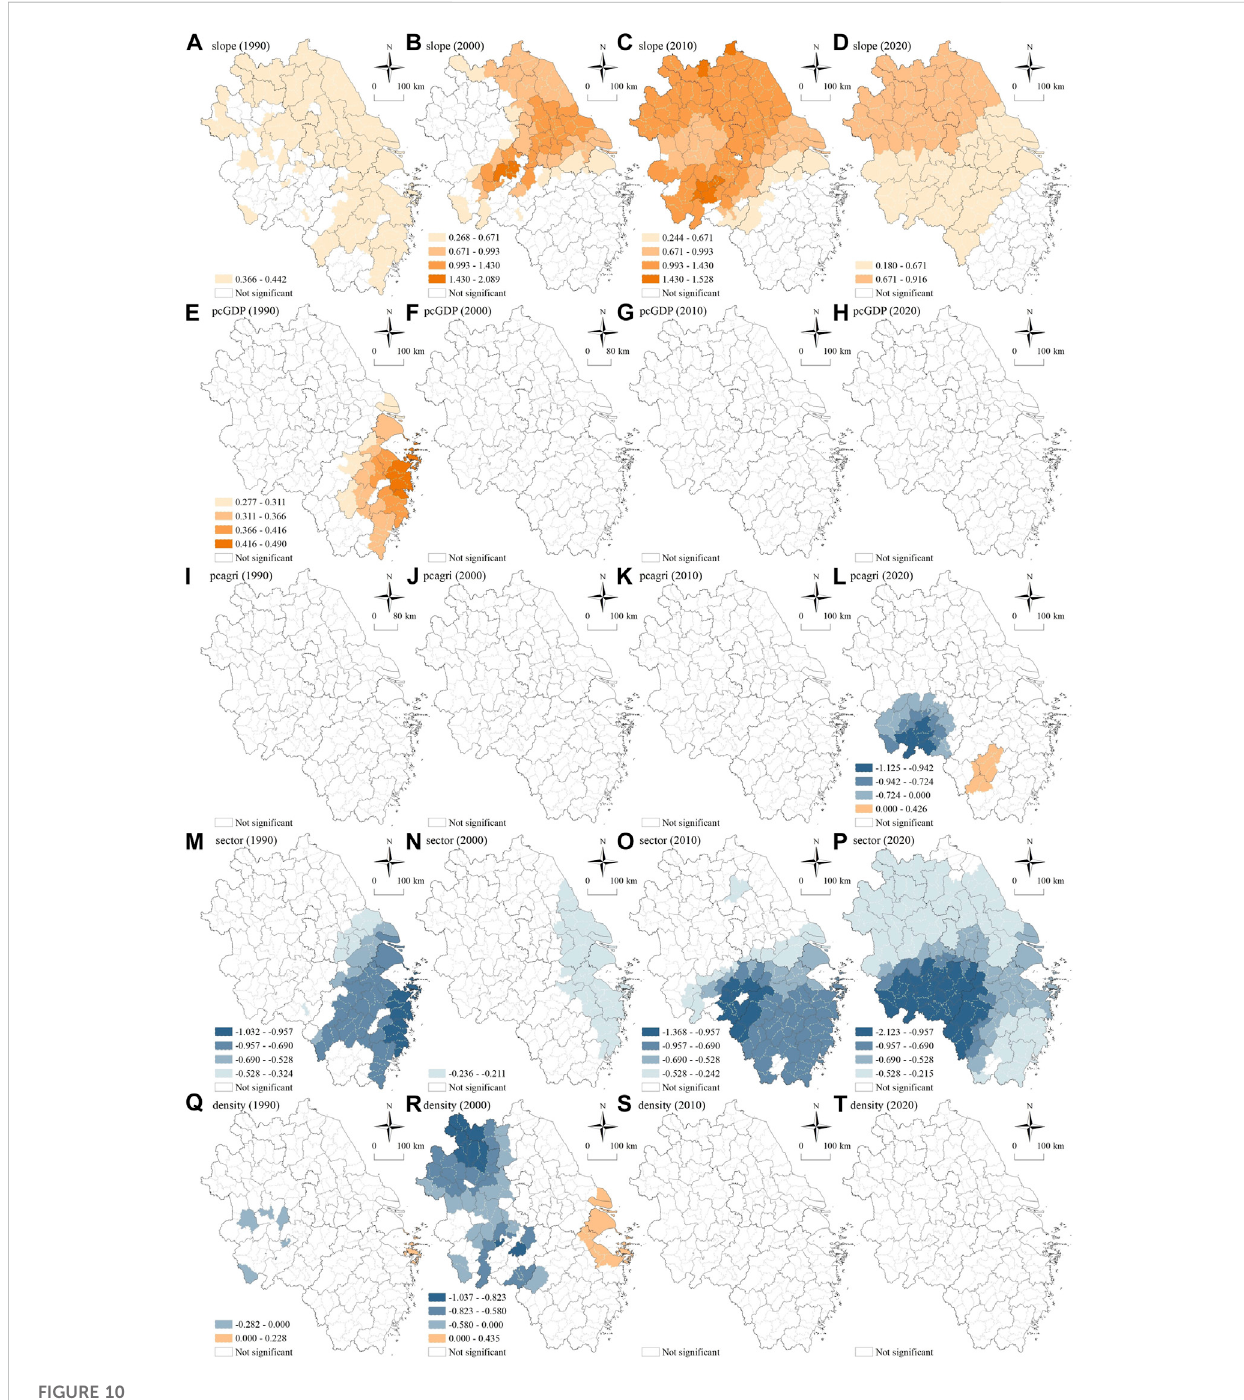
FIGURE 10 Spatial heterogeneity analysis of local